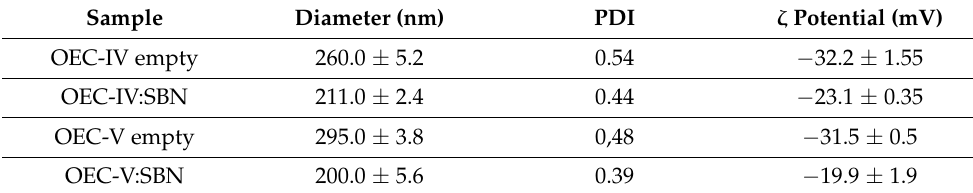
Table 3. Size, size distribution patterns and ζ potential of empty and silibinin-loaded supramolecular aggregates.